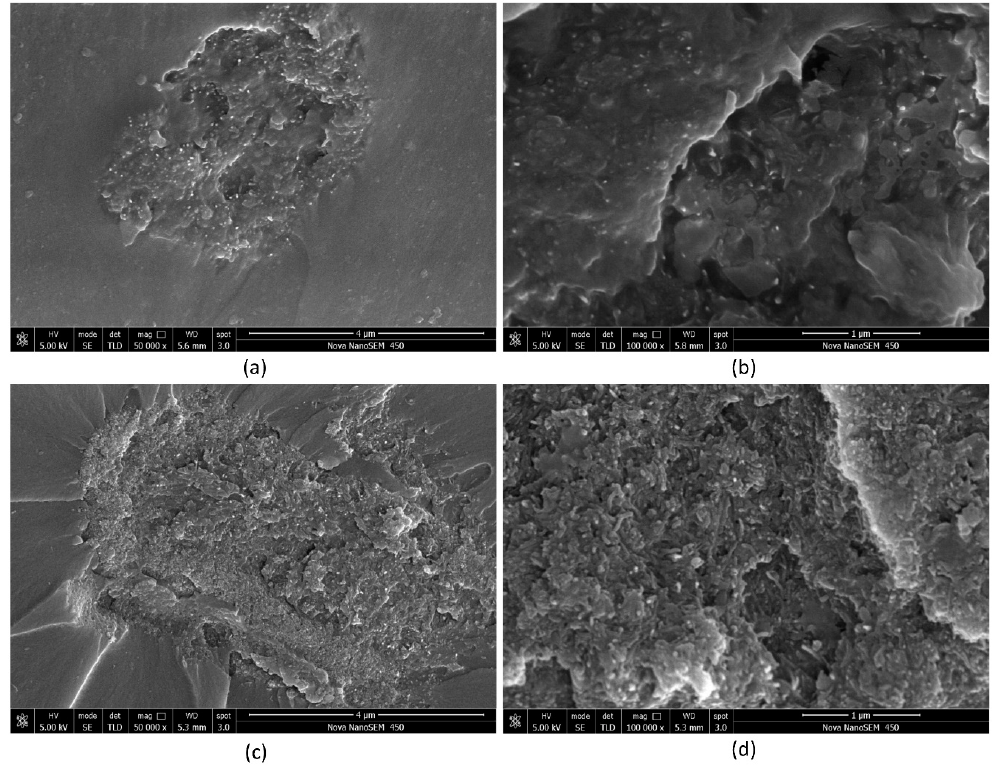
Figure 3. Agglomerates on the fracture surfaces of samples No. 8 (50, 8–15, 0.5) ( a ) and No. 4 (10–30, 20–30, 1) ( c ); internal morphology of the corresponding agglomerates ( b) , ( d ).